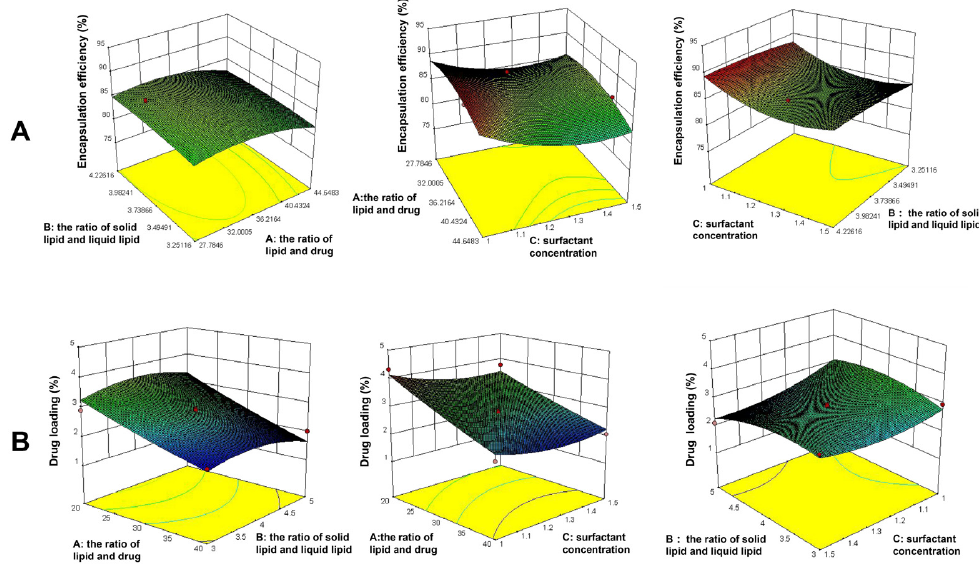
Figure 2. The influence of independent constraints on ( A ) encapsulation efficiency and ( B ) drug loading in 3D response surface plots.